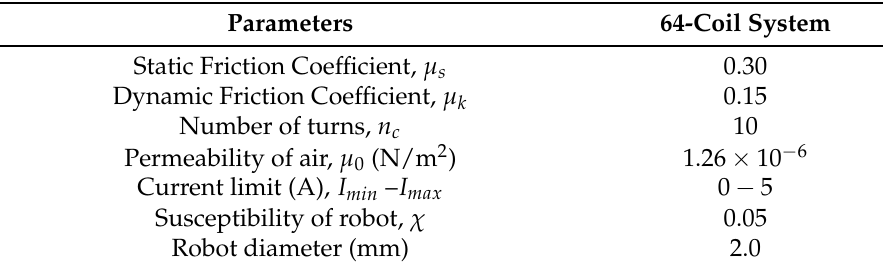
Table 1. Simulation